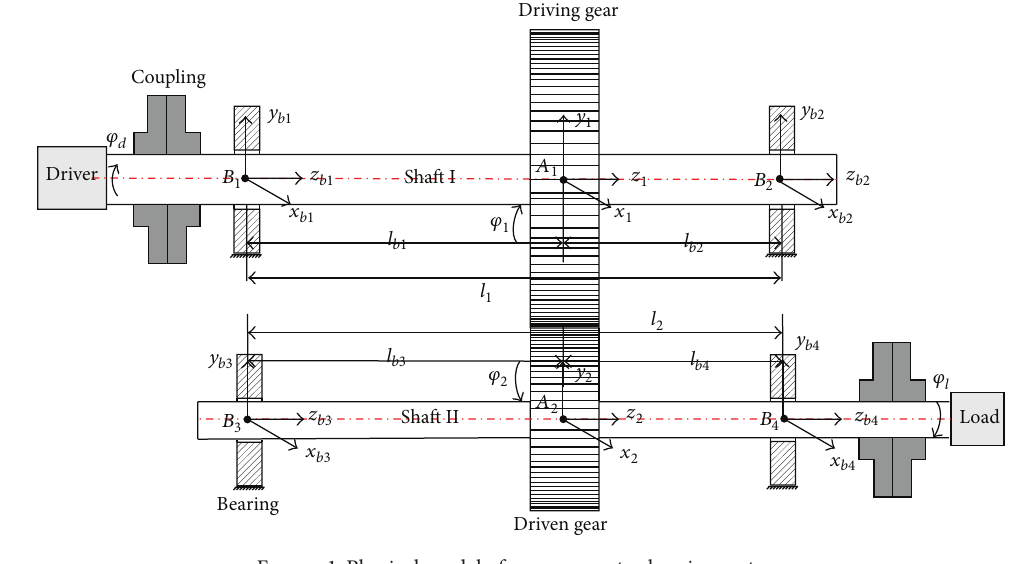
Figure 1: Physical model of spur gear rotor bearing system.